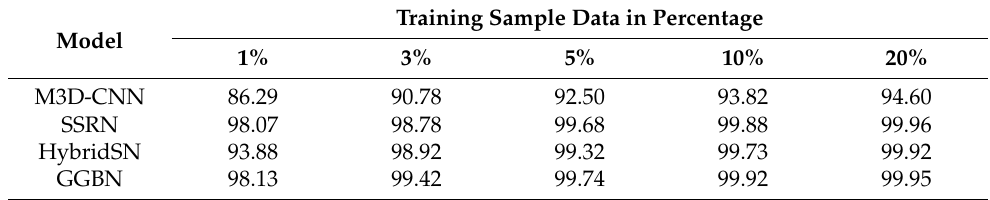
Table 6. Performance of the selected models on varied training sample data over UP dataset.